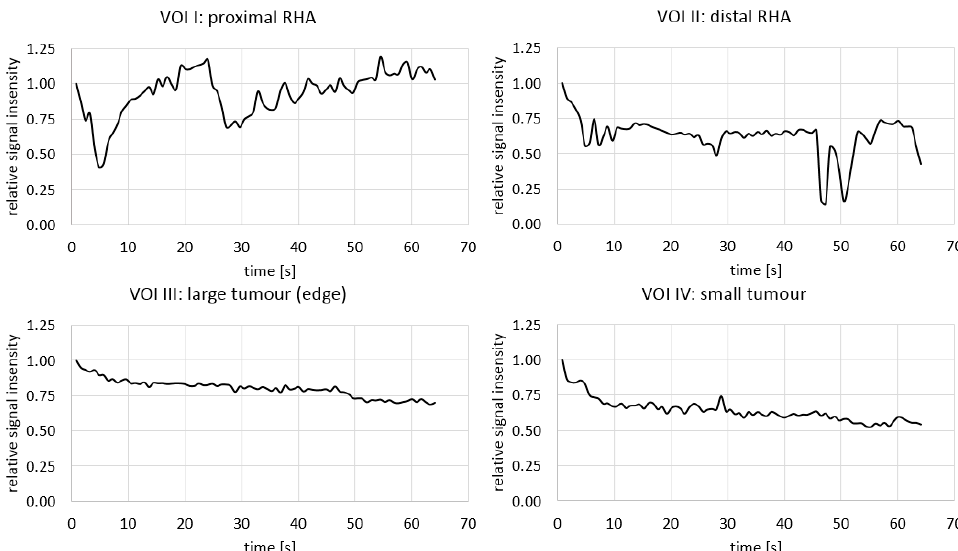
Figure 10. Average of the voxel intensity during near real-time imaging of holmium-166 SIRT in 4 different VOIs: proximal in the right hepatic artery (RHA; corresponding to the arrowhead in Figure 9D), more distal in the RHA (arrowhead in Figure 9E), the edge of the large tumour in segment 4B (top arrowhead in Figure 9F) and one of the smaller tumours (lowest arrowhead in Figure 9F). See Figure 9C for the delineation of the mentioned VOIs.